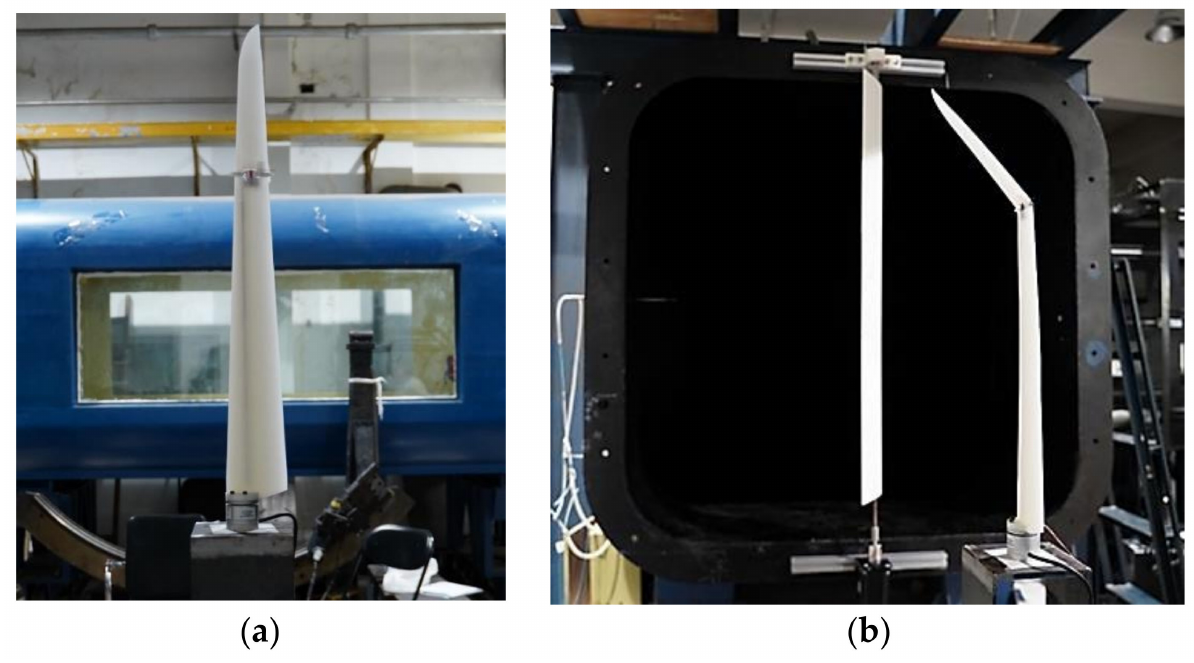
Figure 3. ( a ) The wing model and ( b ) the gust generator installed on the